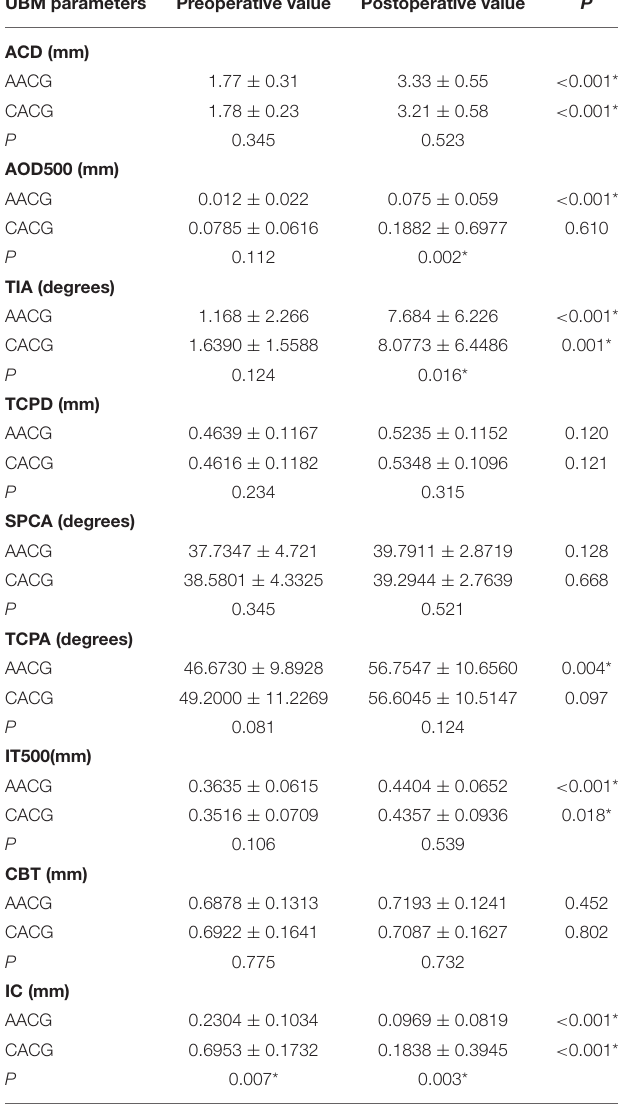
TABLE 4 | Correlation coefficients between preoperative UBM parameters and 1-year postoperative IOP in two groups. Variables